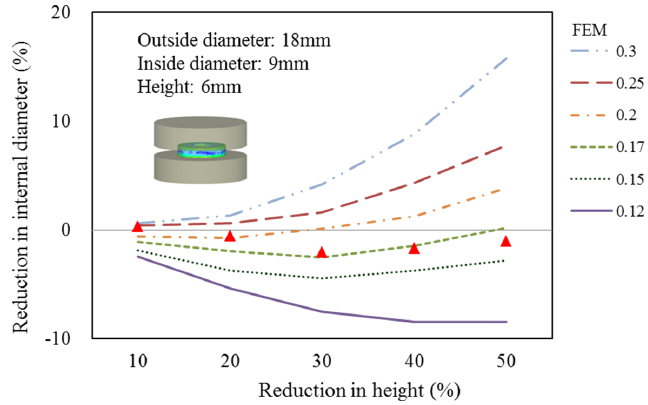
Figure 5. Ring calibration curves obtained with σ = 568.17 ε 0.09 (MPa).